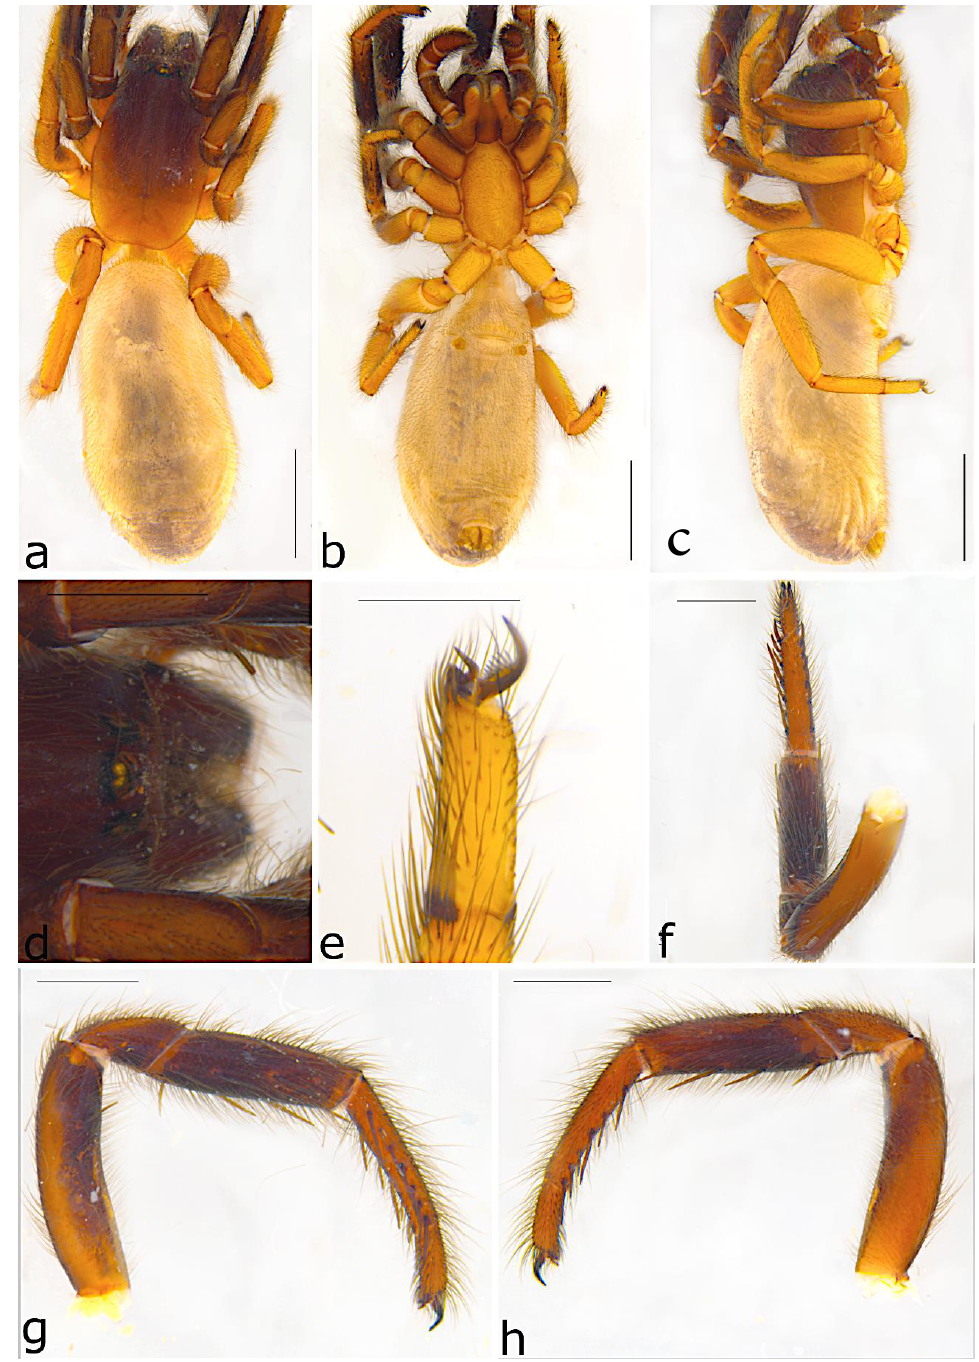
Figure 67. Ariadna ungua sp. nov. ♀ paratype (SAMA NN31203) from Lake Dam, near Lake Frome/Munda (SA): ( a ) habitus, dorsal view; ( b ) same, ventral view; ( c ) same, lateral view; ( d ) eyes, dorsal view; ( e ) left metatarsus IV, preening comb, retrolateral view; ( f ) left leg I, ventral view; ( g ) same, prolateral view; ( h ) same, retrolateral view. Scale bars ( a – c ) = 2 mm, ( d ) = 1 mm, ( e ) = 0.5 mm and ( f – h ) = 1